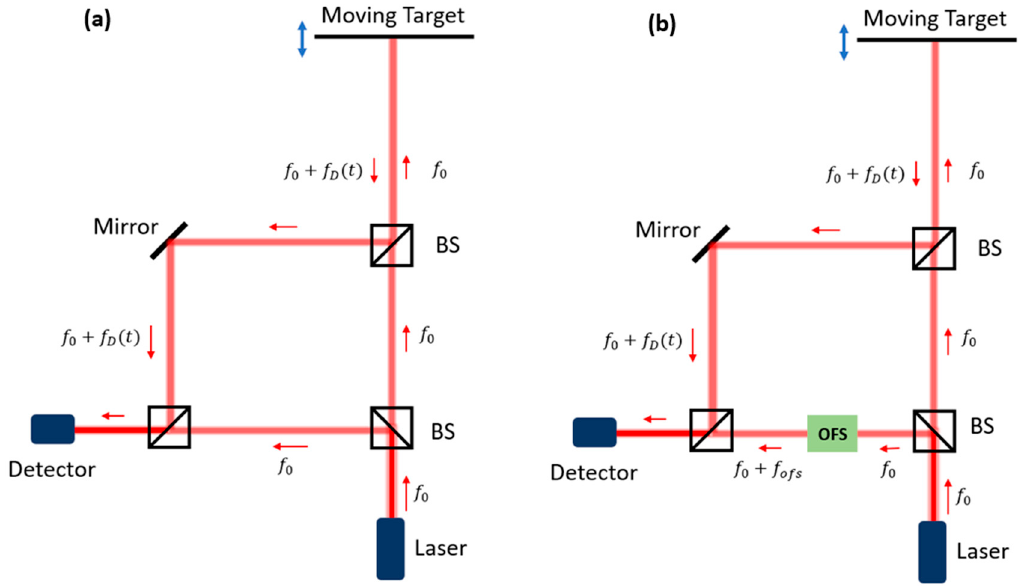
Figure 2. Schematic diagram of ( a ) homodyne interferometer and ( b ) heterodyne interferometer. A beam splitter (BS) creates the reference and measurement arms of the interferometer. The heterodyne interferometer has an optical frequency shifter (OFS) in the reference arm. One can also use polarization beam splitters and quarter-wave plates in the LDV system to improve the coupling efficiency of reflection and the isolation of the laser source. However, they are not mentioned in the plotted system in this figure to simplify the schematic of the system.